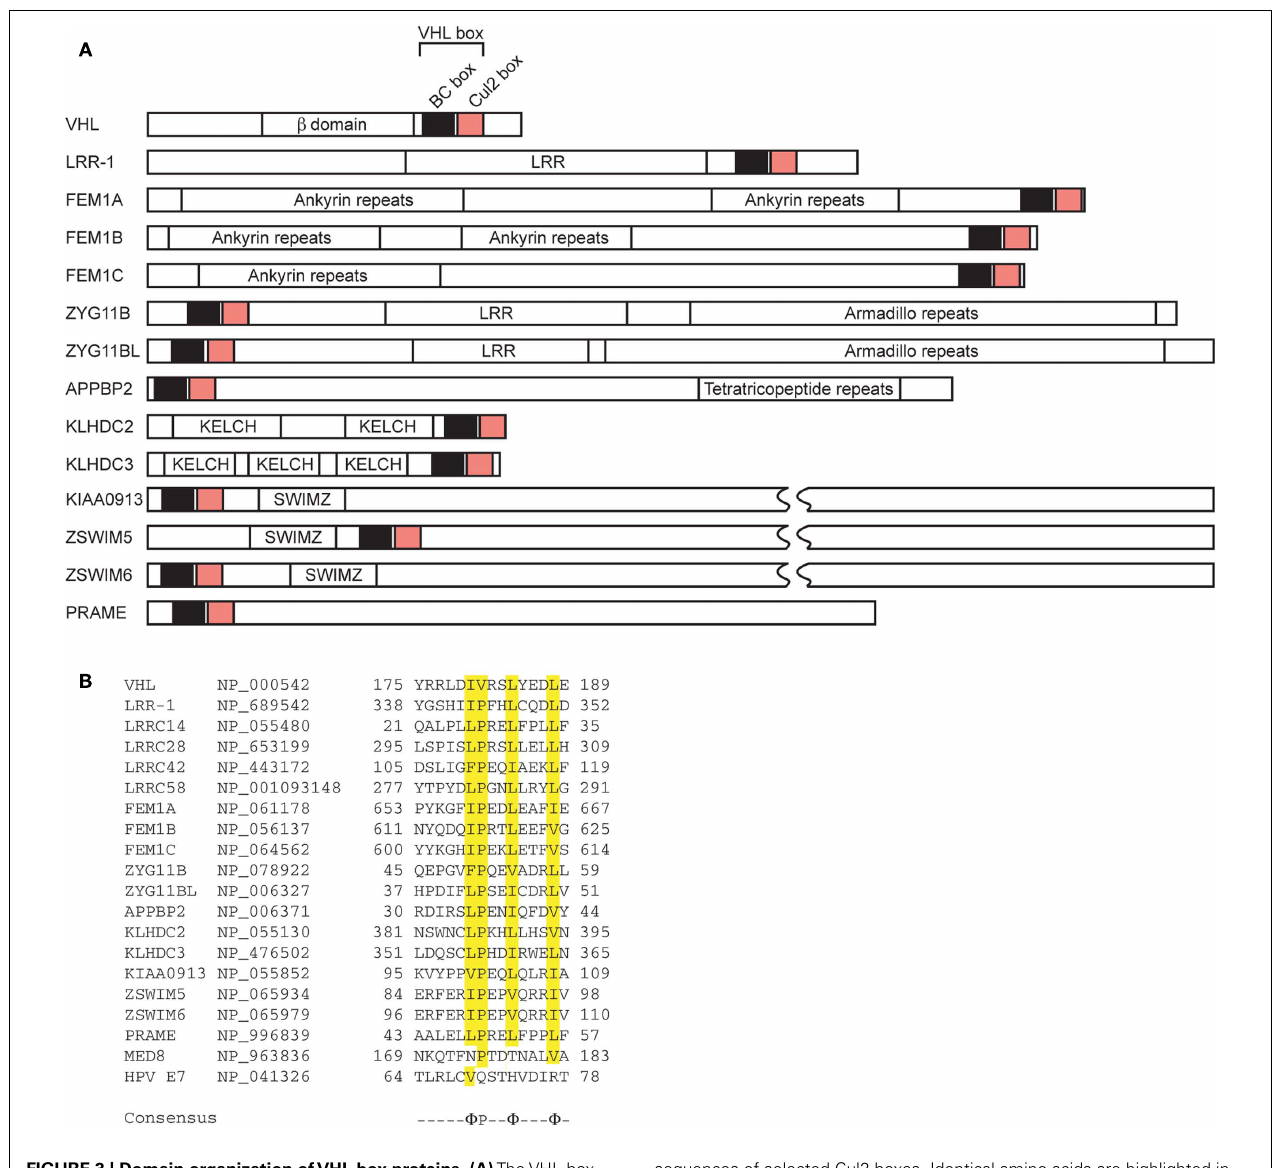
FIGURE 3 | Domain organization ofVHL box proteins. (A) TheVHL box consists of a BC box and a Cul2 box in the order indicated. LRR, leucine-rich repeats; SWIMZ, SWI2/SNF2 MuDR zinc fingers. (B) Alignment of amino acid